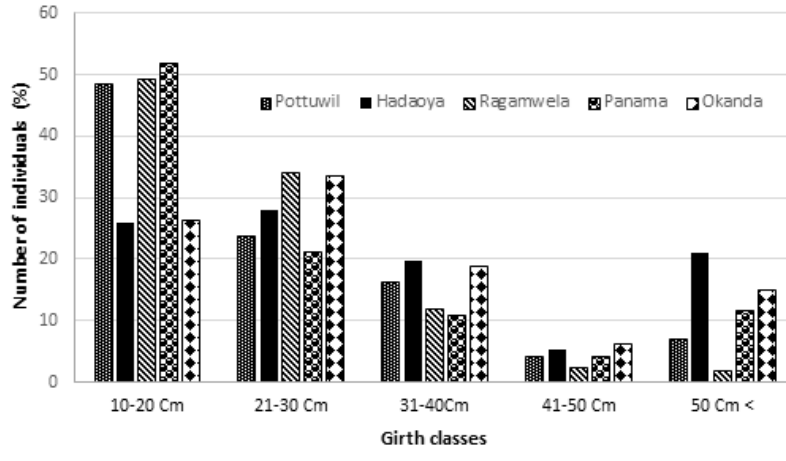
Figure 2: Girth classes distribution of individuals of mangrove species in each study site.